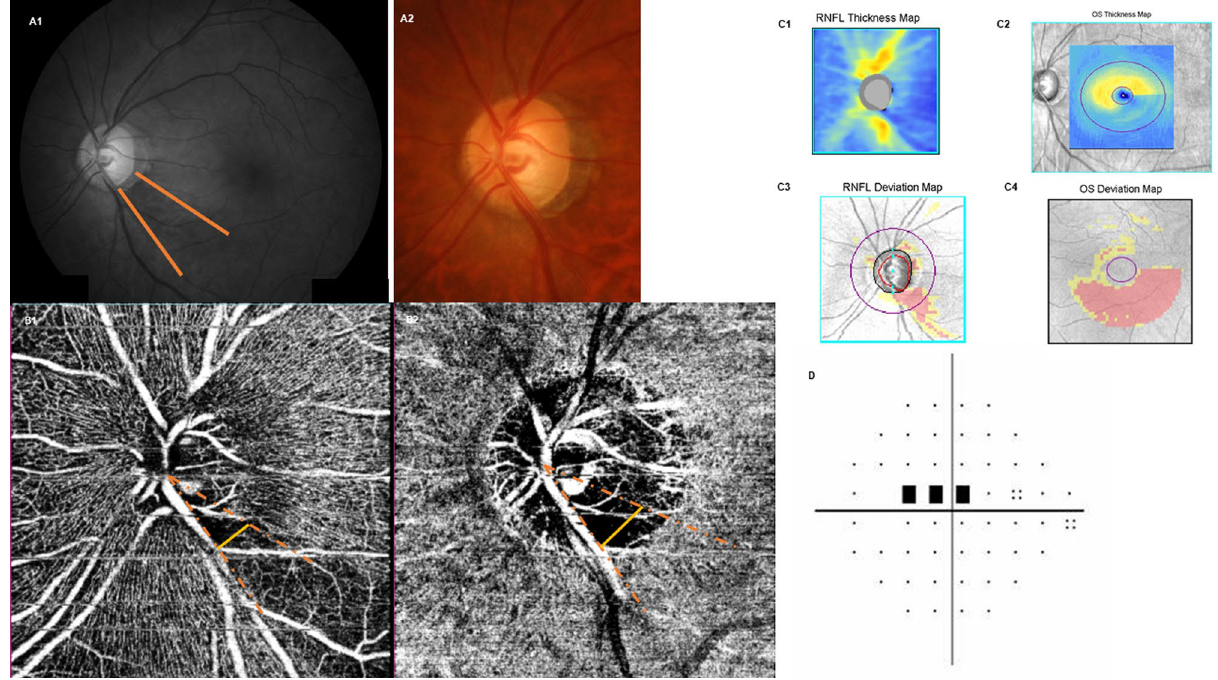
Figure 3. A Representative case of wider localized vessel density defect on the deep layer. A 63-year-old man with normal-tension glaucoma presented with localized inferotemporal retinal nerve fiber layer defect ( A , C ) and a paracentral visual field defect ( D ). The signal strength index of optical coherence tomography angiography (OCTA) was 68, and there was the wider vessel density defect in the deep layer map than that of the superficial layer map on OCTA (B-1 and 2, 37.55° and 28.29°, respectively).